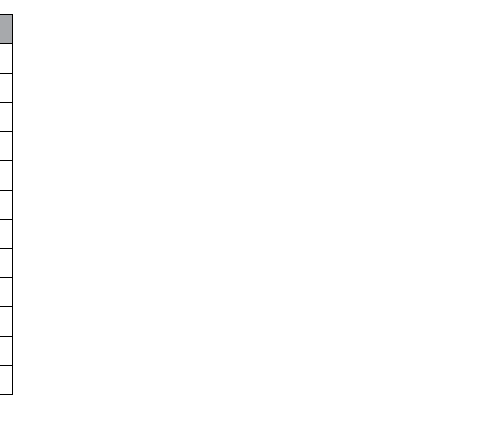
Table 3. ARIMA analysis for meteorological